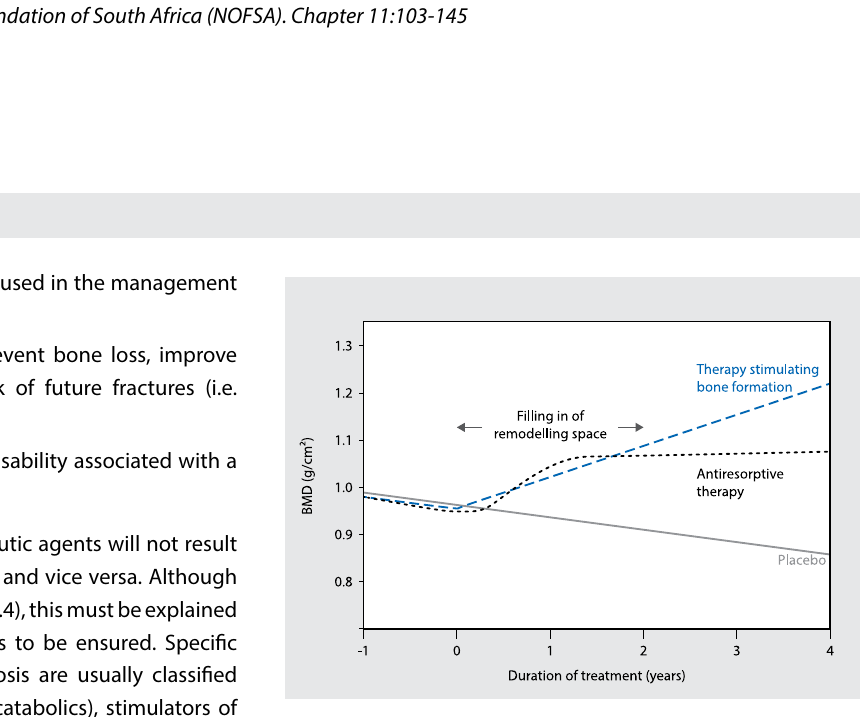
Figure 7: Effects on BMD after treatment with ARAs and bone formation-stimulating drugs. Adapted from Parfitt305 and